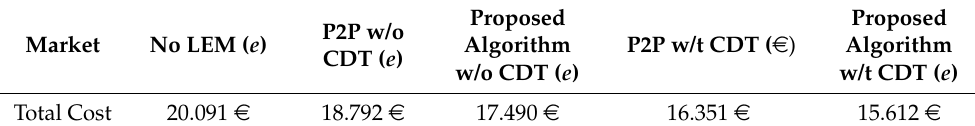
Table 1. Total Daily Cost in Euros.